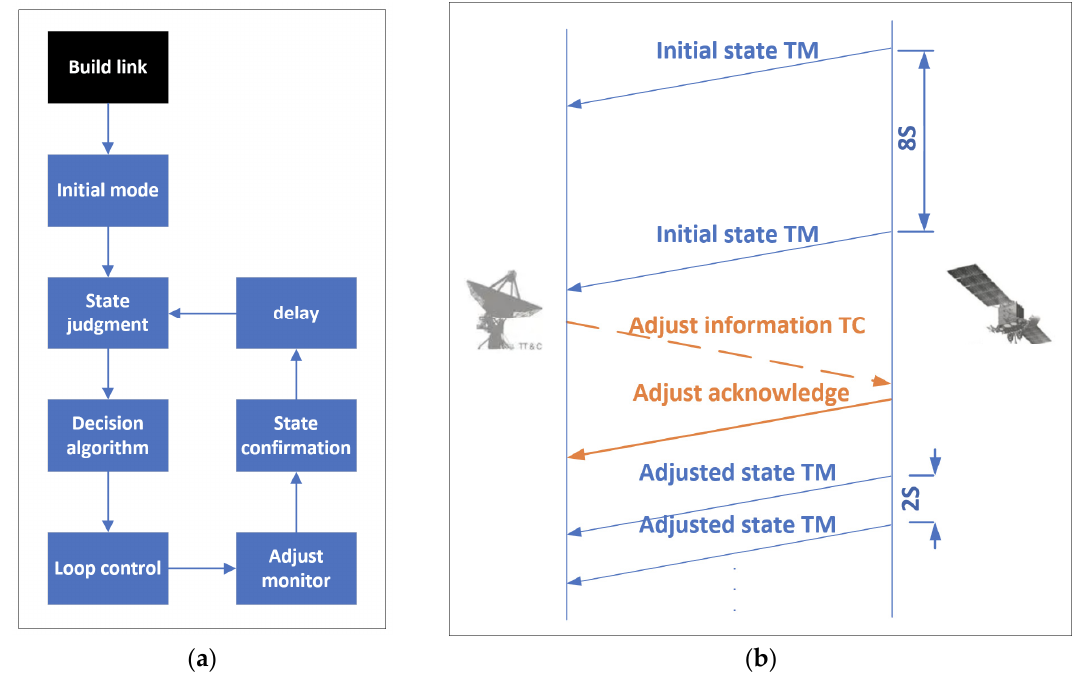
Figure 11. ( a ) Adaptive adjustment flow chart; ( b ) self-loop diagram.